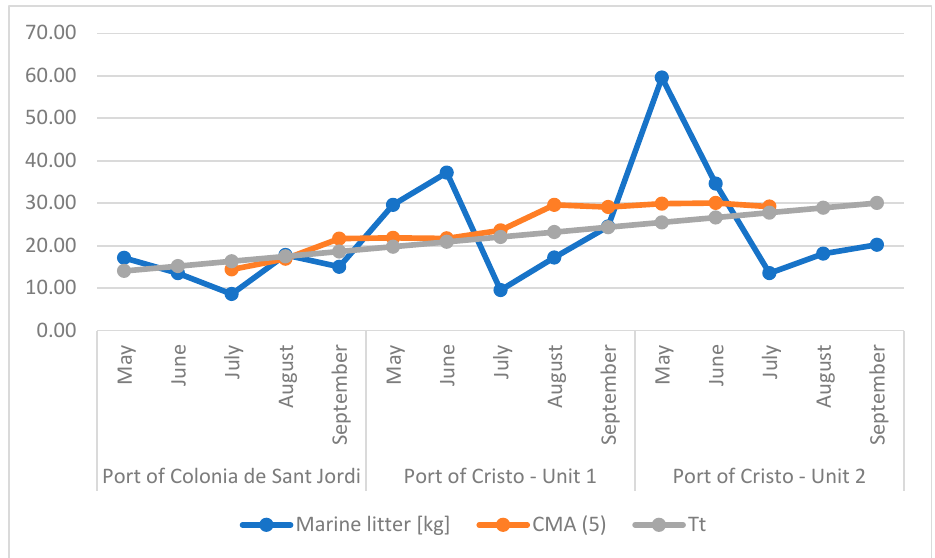
Figure 9. Monthly time series of the weight of marine litter collected at each site in 2021.